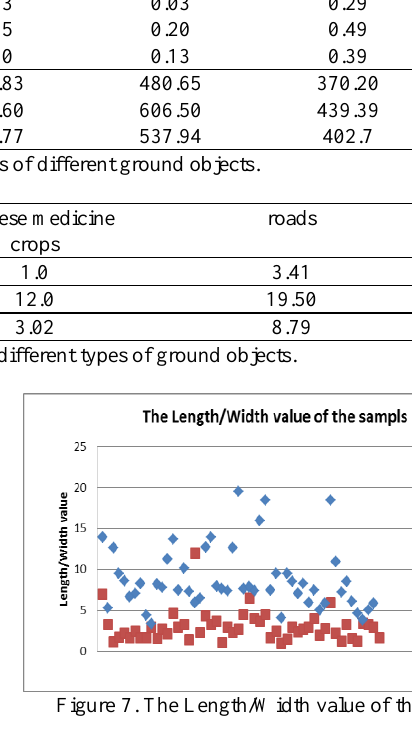
Figure 5. The NDVI value of the samples